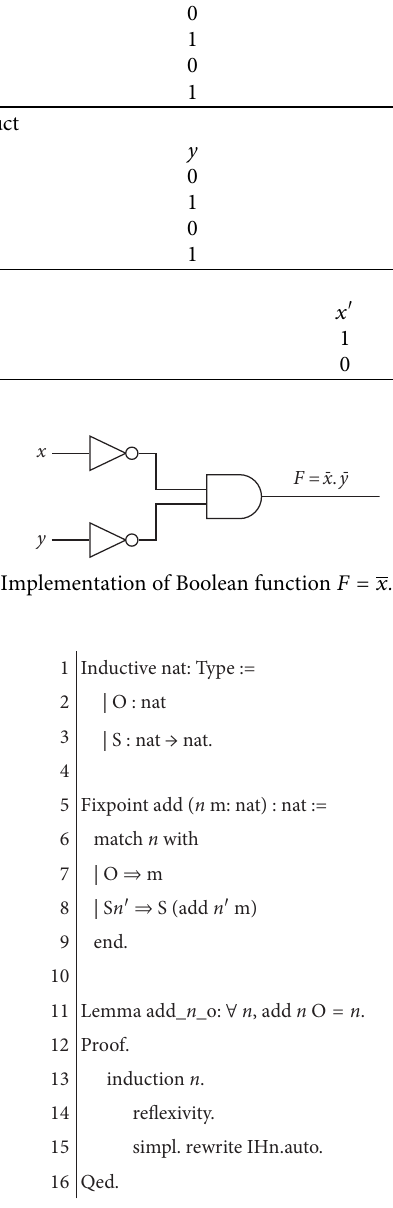
Figure 3: Interactive formal proof in